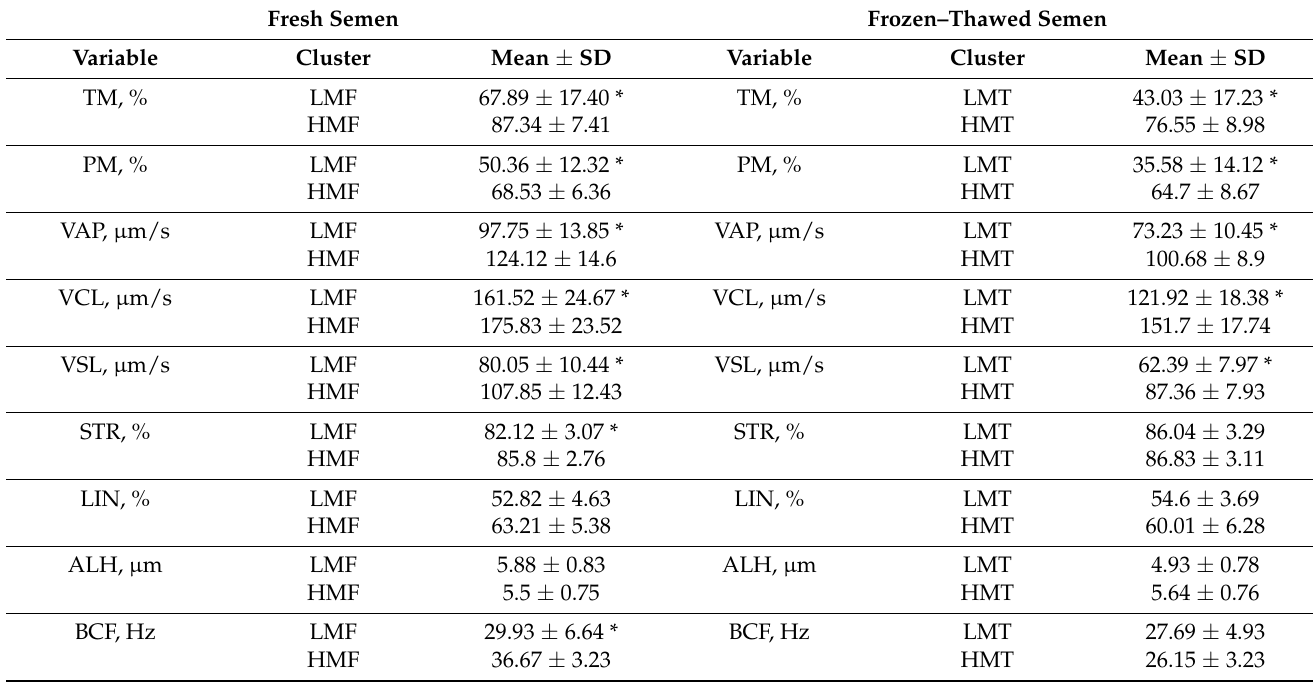
Table 1. Motility parameters of fresh (FR) and frozen–thawed (FT) semen in high-motility and low-motility clusters (respectively HMF and LMF for FR semen and HMT and LMT for TH semen).